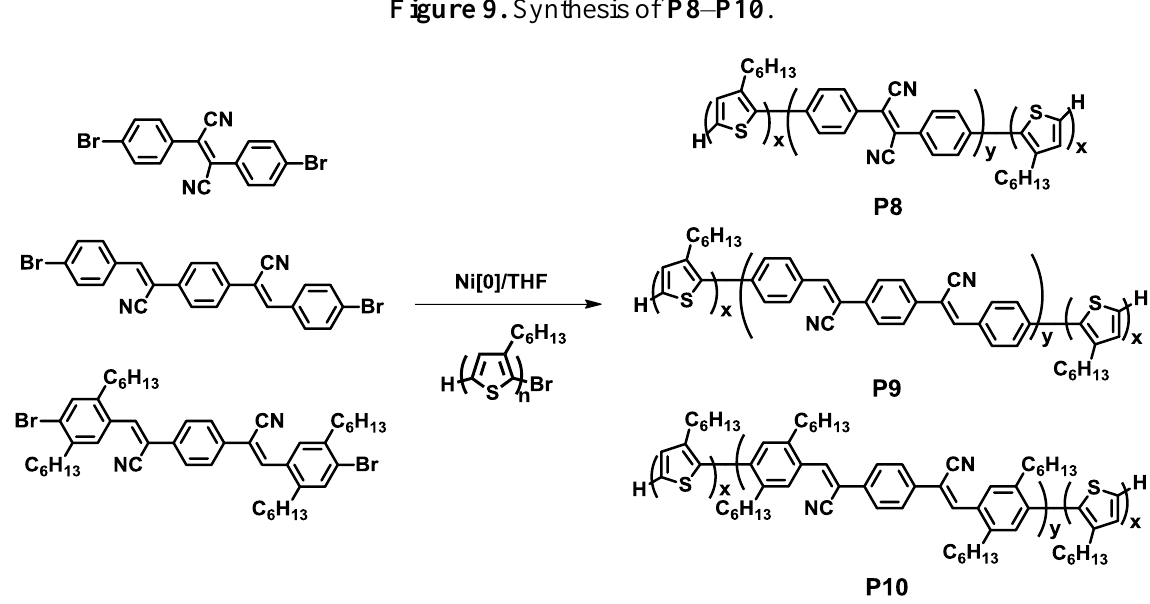
Figure 9. Synthesis of P8 – P10